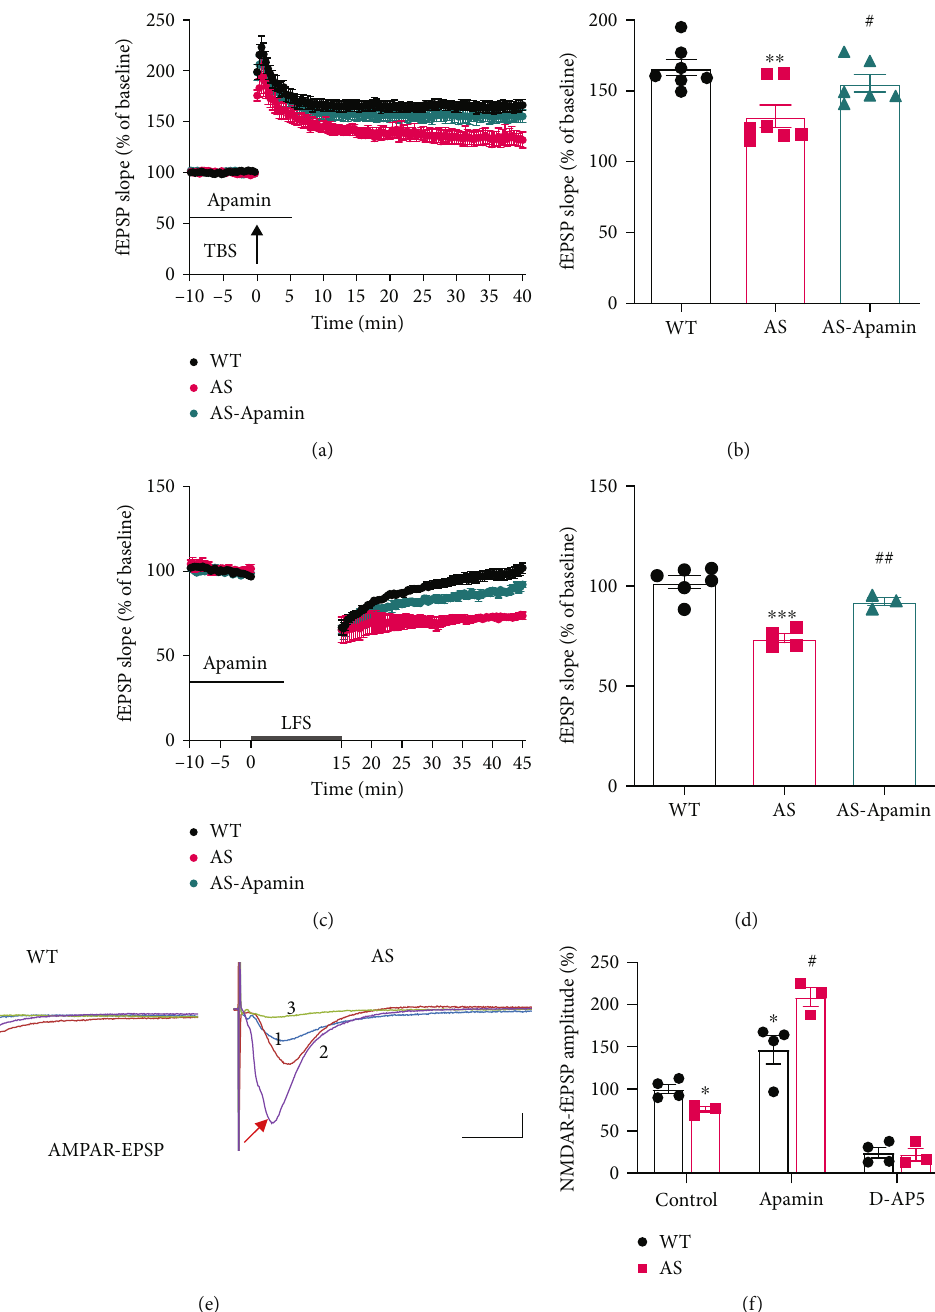
Figure 3: Impairment of NMDA receptor-dependent hippocampal synaptic transmission and activity-dependent synaptic plasticity in hippocampal slices from female AS mice. (a) Reversal of LTP impairment in AS mice by SK2 channel blocker, apamin. Slopes of fEPSPs were normalized to the average values recorded during the 10-min baseline. (b) Means ± SEM of fEPSPs measured 40min after TBS in di ff erent groups. N = 6 − 7 slices from 4-5 mice, ∗∗ P < 0 : 01 , # P < 0 : 05 (one-way ANOVA followed by Dunnett ’ s test, F ð 2, 17 Þ = 7 : 122 ). (c) LTD in hippocampal slices from AS mice is blocked by apamin. (d) Means ± SEM of fEPSPs measured 45min after LFS in di ff erent groups. N = 3 − 6 slices from 3 mice, ∗∗∗ P < 0 : 001 , ## P < 0 : 01 (one-way ANOVA followed by Dunnett ’ s test, F ð 2, 10 Þ = 25 : 50 ). (e) and (f ) E ff ects of apamin treatment on NMDAR-mediated synaptic responses (NfEPSPs). (e) Representative traces. (1) Mg 2+ -free aCSF containing 10 μ M CNQX (control), (2) Apamin treatment, (3) D-AP5 treatment. Scale bar, 0.5mV/10ms. (f) Quanti fi cation of NfEPSPs. Data are means ± SEM expressed as % of values in WT hippocampal slices before apamin treatment (WT control). N = 3 − 4 slices from 3 mice, ∗ P < 0 : 05 , # P < 0 : 05 (two-way ANOVA followed by the Tukey test; for genotype, F ð 1, 15 Þ = 2 : 126 , for treatment, F ð 2, 15 Þ = 115 : 8 , for interaction, F ð 2, 15 Þ = 9 : 899 ). Traces of AMPAR fEPSPs indicate that synaptic responses before initiation of NfEPSP recording are similar between AS and WT